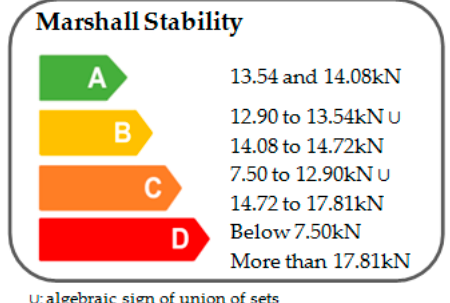
Figure 11. Marshall stability labels based on the type of mixture.